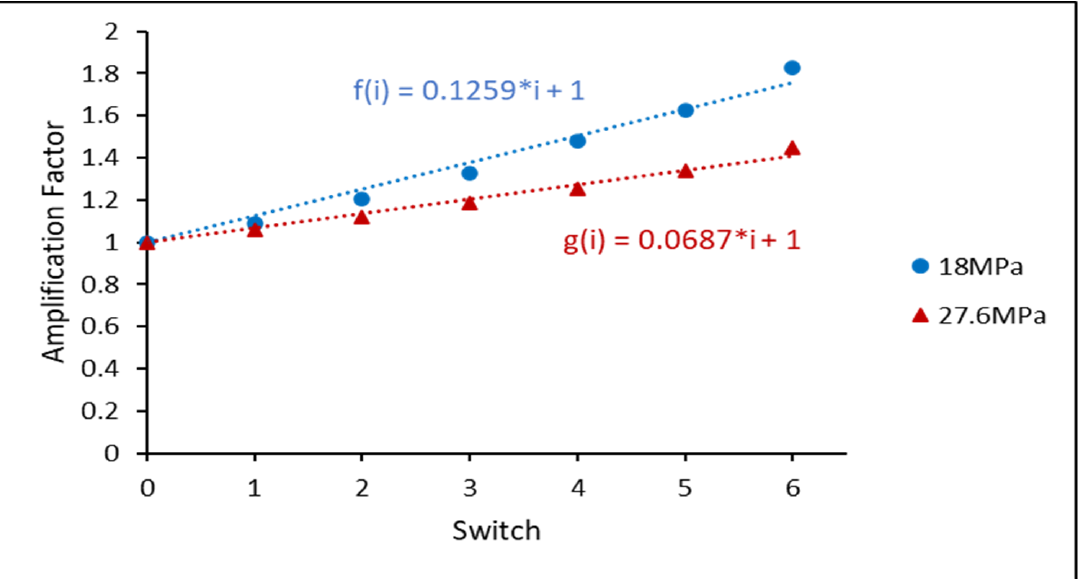
Figure 11. Amplification factor of non-aged SAC305 individual soler joint in varying stress amplitude test (18 MPa–27.6 MPa).